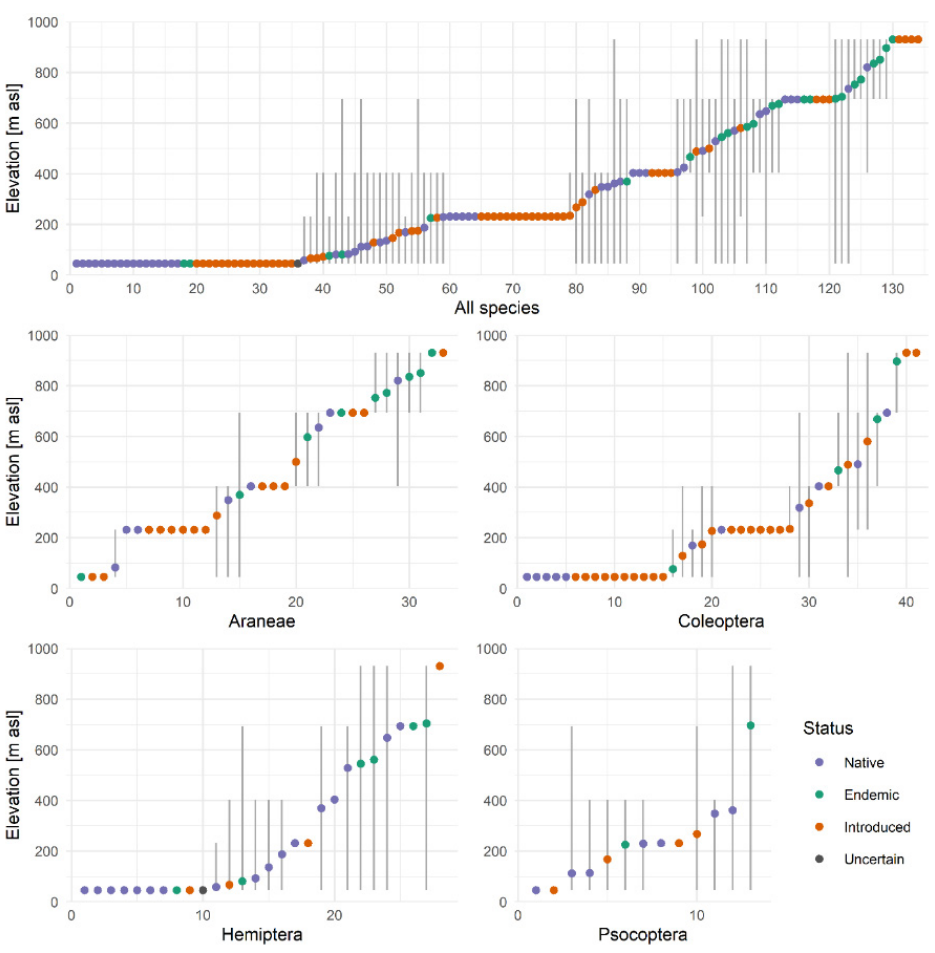
Figure 2. Altitudinal ranges along the elevation gradient of Terceira island, represented by five sampling sites at 46, 231, 404, 693 and 930 m a.s.l., for all species and for the orders Araneae, Coleoptera, Hemiptera and Psocoptera (species numbers are on the x -axes). The graphs show each species’ range, assuming continuous ranges between the minimum and maximum recorded elevations, and the abundance-based mean elevation of all records. Species are sorted by mean elevation. Colours indicate native (but non-endemic) species (blue), endemic species (green) and introduced species (orange), while one Hemiptera species has an uncertain status (grey). Many species were only recorded at one site. The highest species richness among different orders was found at low elevations, especially for introduced species, but not for endemic species and Araneae. Supporting Information Table S1 lists all species shown here.